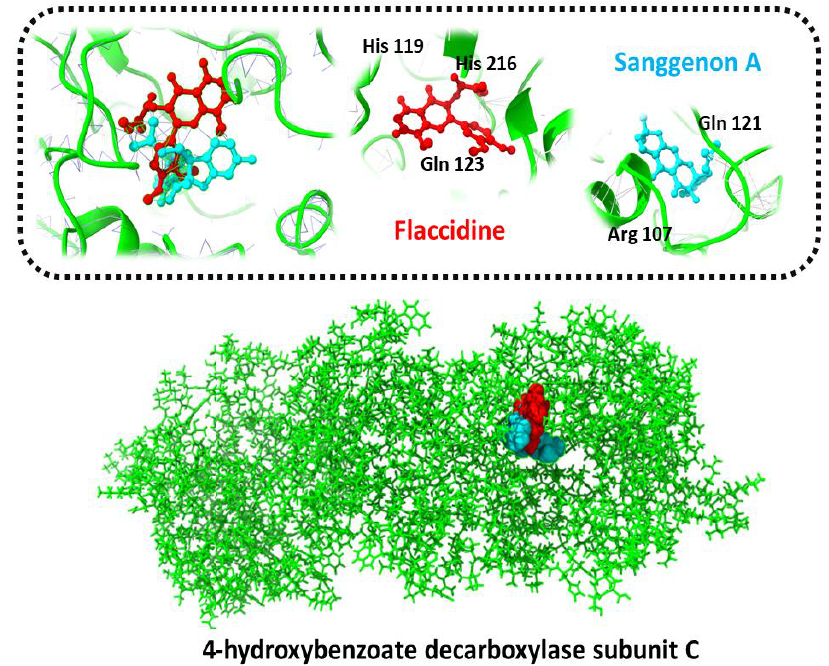
Figure 4. Three-dimensional representation of molecular docking analysis and the interaction of Sanggenon A and Flaccidine inhibitors with 4-hydroxybenzoate decarboxylase subunit C. Andromedotoxin and Sophorose, in complex with the Oligopeptide Binding Protein, showed the lowest docking score along with a strong hydrogen bond interaction. The LigX tool was used to predict the interacting residues of the receptor and ligand, which indicate that Andromedotoxin and Sophorose showed strong bindings with the side chains of Ser 321, Ser 323, Gln 368, Ser223, Thr 370, and Gln 354, as shown in Figure 5.